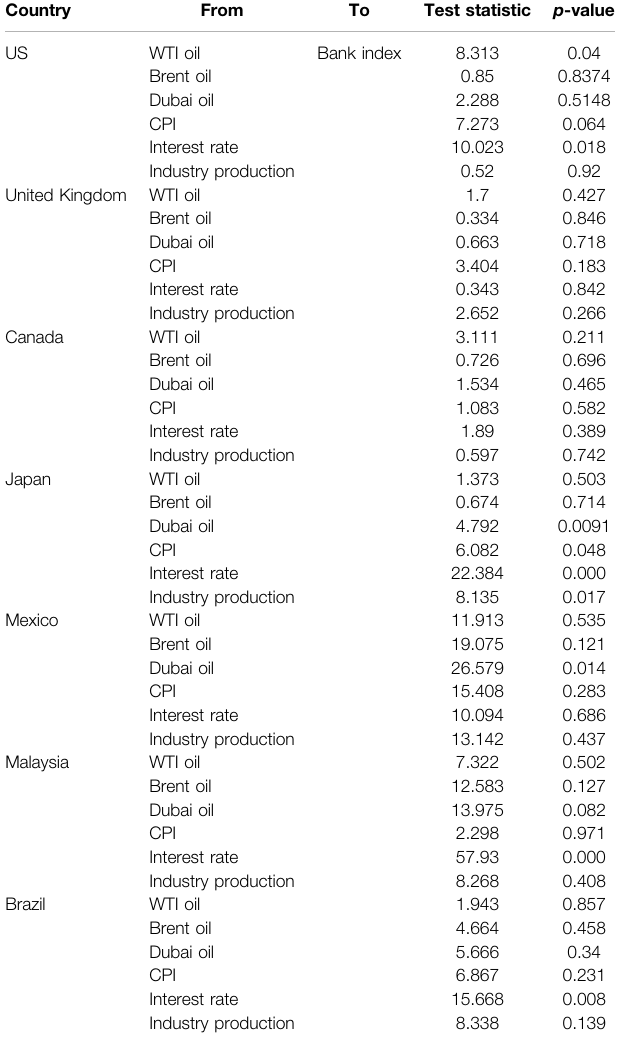
TABLE 4 | Causality test. Country From